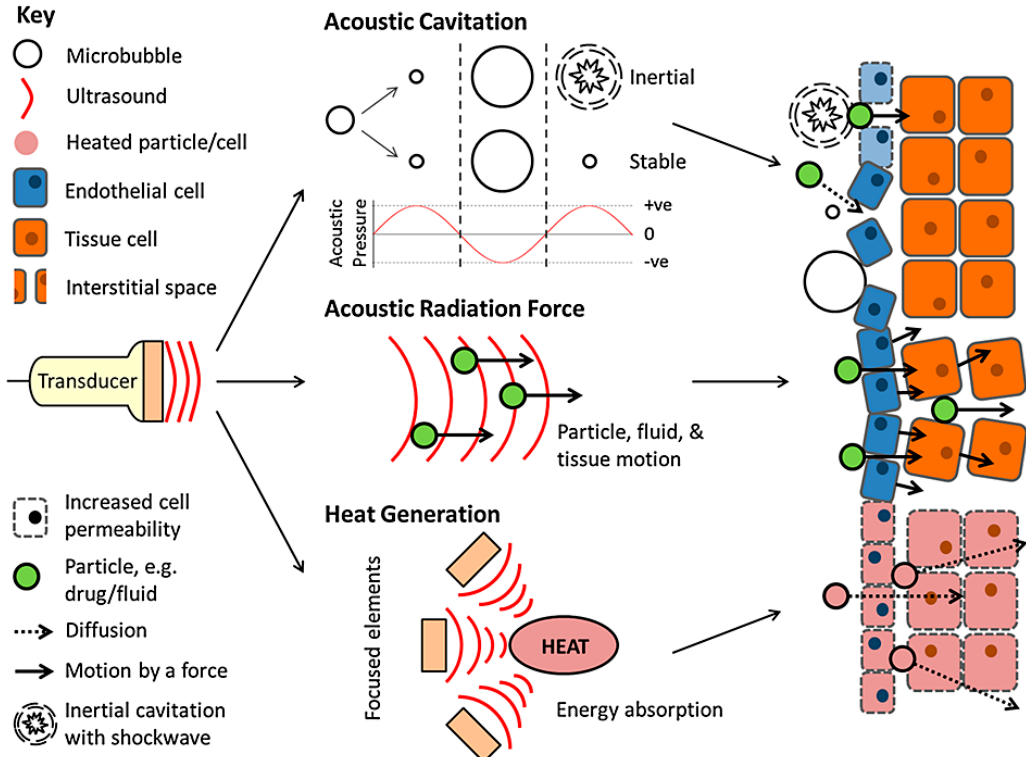
Figure 2. Illustration of mechanisms involved in ultrasound-mediated delivery. These can be divided into the mechanical effects of acoustic cavitation and acoustic radiation force, and thermal effects. Reprinted by permission from John Wiley and Sons, Journal of Labelled Compounds and Radionuclides [28].